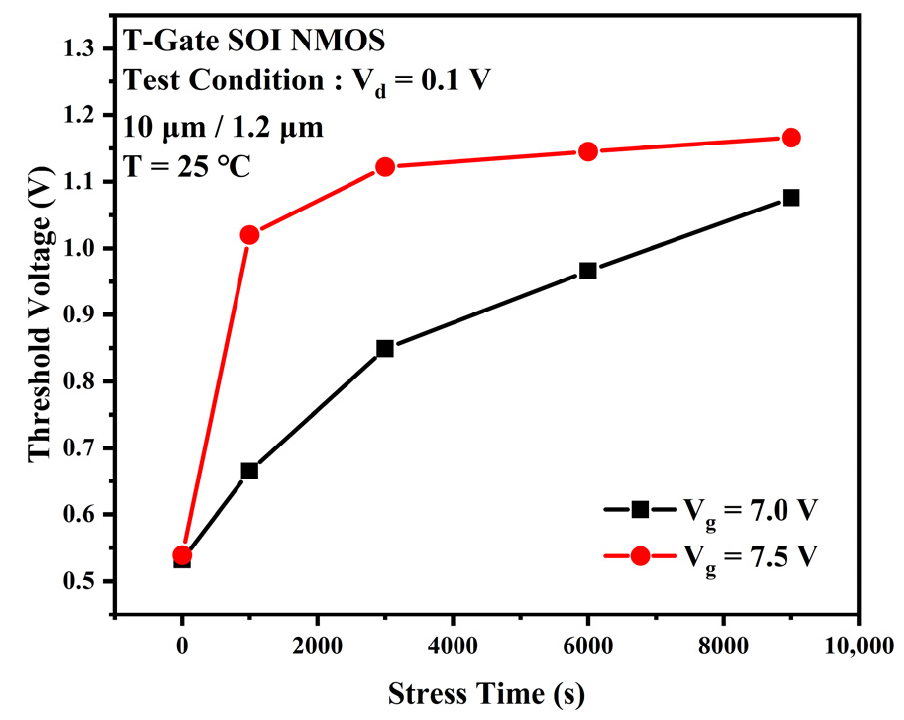
Figure 3. Degradation of the device threshold voltage when the TDDB stress is applied.